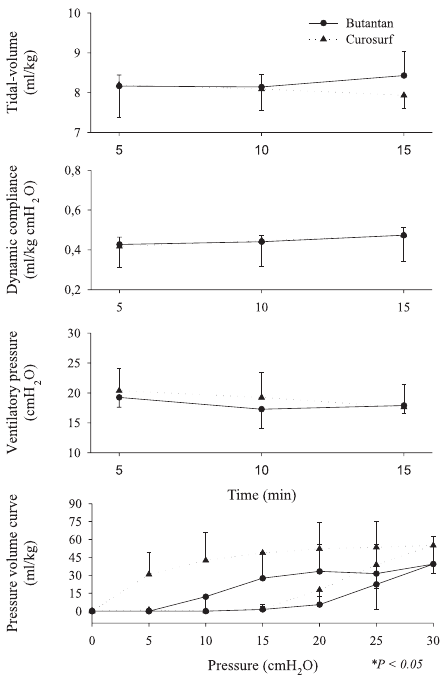
Figure 6 - Time point 4 (90 days after being kept at 20 o C-water bath temperature before being warmed to 37 o C for 5 minutes) data for tidal- volume (V ), dynamic compliance (DC), ventilatory pressure (VP), and t pressure-volume curve (mean ± SD). Data were analyzed by the Student t test (parametric data) or Mann-Whitney test (nonparametric